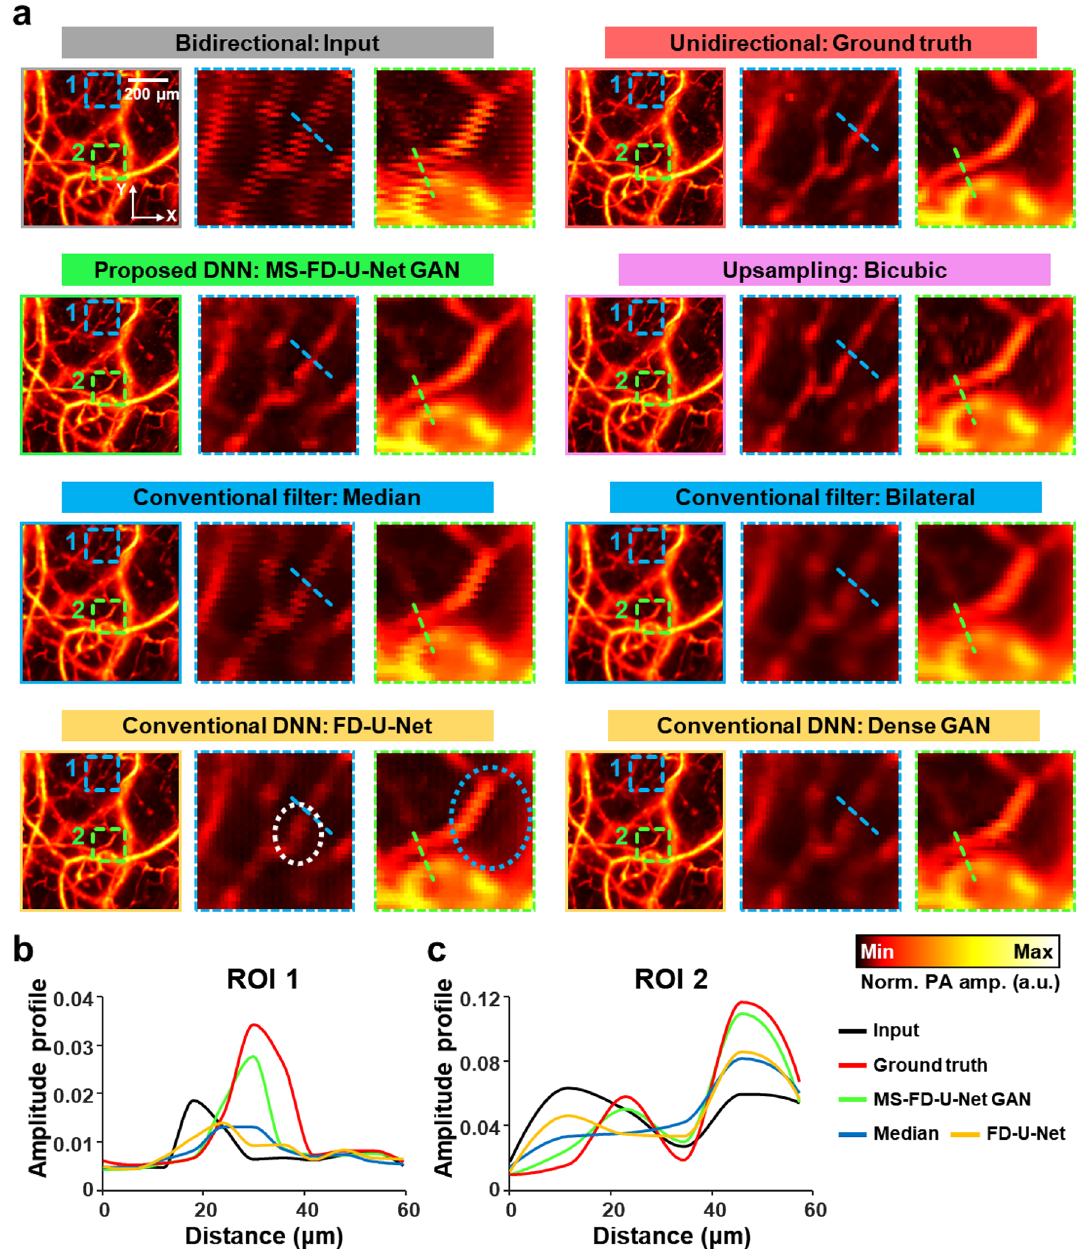
Figure 3. Performance comparison of the MS-FD-U-Net with other existing methods. ( a ) OR-PAM images reconstructed with bidirectionally (marked as Input) and unidirectionally (marked as Ground truth) acquired data, the MS-FD-U-Net GAN, an upsampling method (i.e., bicubic interpolation), conventional filtering methods (i.e., bilateral and median filtering), and other DNNs (i.e., Dense GAN and FD-U-Net). PA amplitude profiles from the regions highlighted by the ( b ) blue and ( c ) green dashed lines in ( a ), respectively. The graphs display the profiles in the images of Input, Ground truth, MS-FD-U-Net GAN, FD-U-Net and median filtering. The graphs for other methods (i.e., bicubic, bilateral filtering and dense GAN) are displayed in Supplementary Fig.